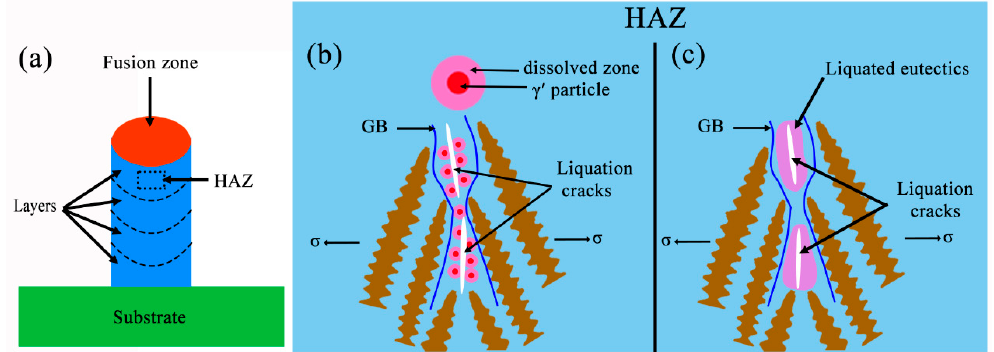
Figure 14. Schematic diagram of two liquation mechanisms, ( a ) the location of heat-affected zone (HAZ), ( b ) constitutional liquation of γ′ particles, and ( c ) localized melting of γ – γ′ eutectics.